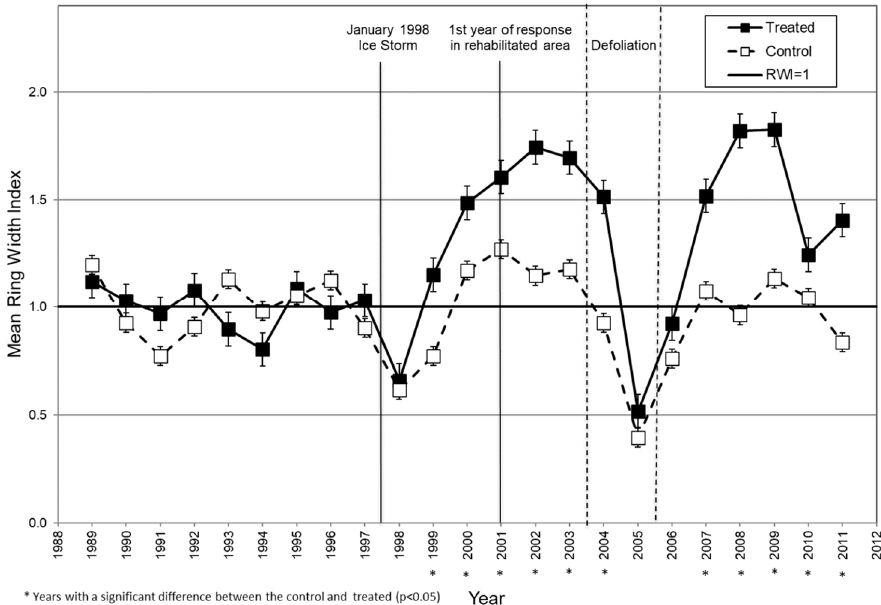
Figure 4. Taylor Creek annual pattern of mean RWI for 9 years prior to and 13 years after the January 1998 ice storm with standard error ( ± 0.1030), and the recovery pattern after a 2-year (2004–2005) defoliation by the forest tent caterpillar. Years with significant differences in the mean ring width index between treatment groups are designated by an asterisk ( p < 0.05).